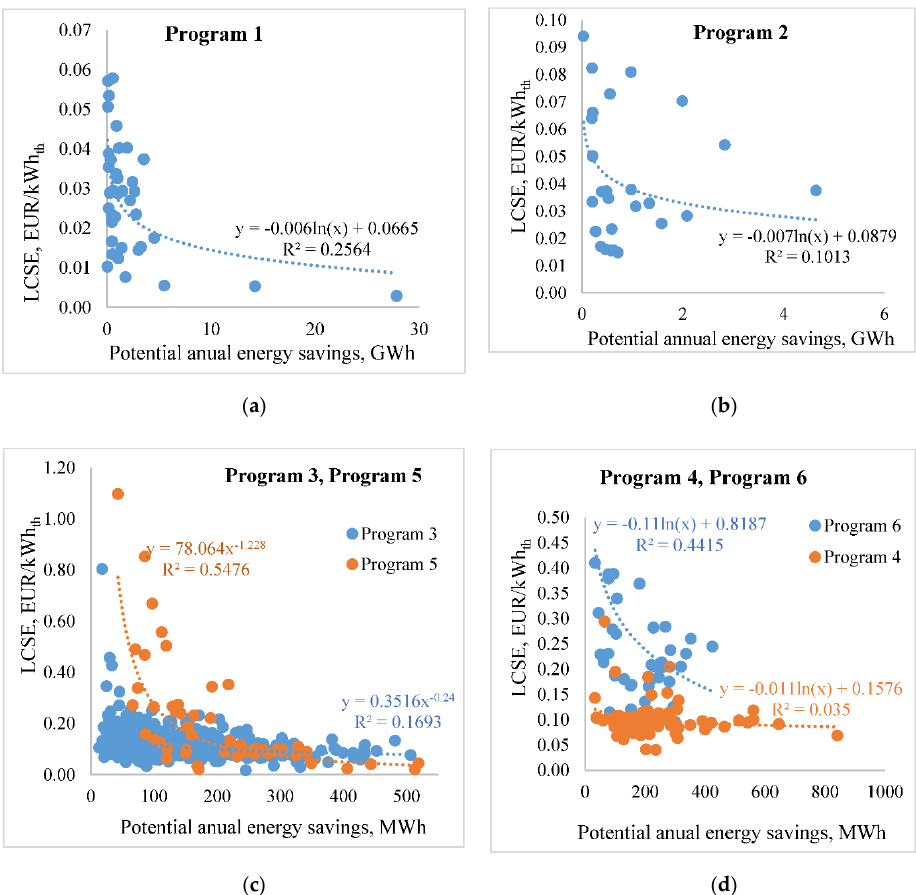
Figure 6. Regression analyses for analysed energy e ffi ciency programs: ( a ) Program 1 for manufacturing companies; ( b ) Program 2 for district heating companies; ( c ) Program 3 and Program 5 for apartment building renovation; ( d ) Program 4 and Program 6 for municipalities’ building renovation.